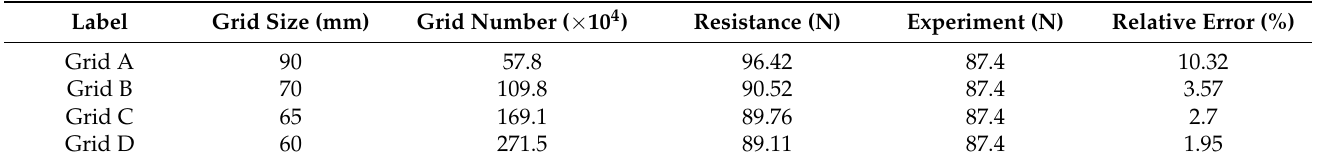
Table 1. Grid convergence study.